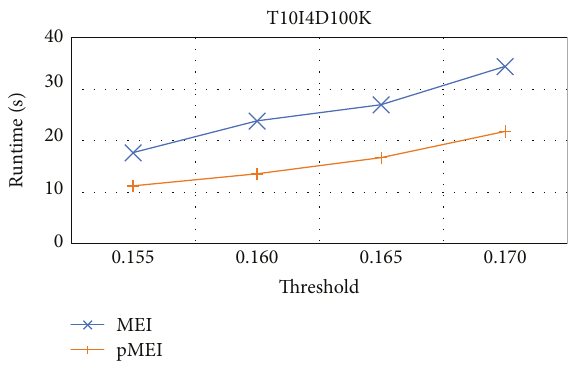
Figure 4: Runtimes of the MEI and pMEI methods on the Connect.